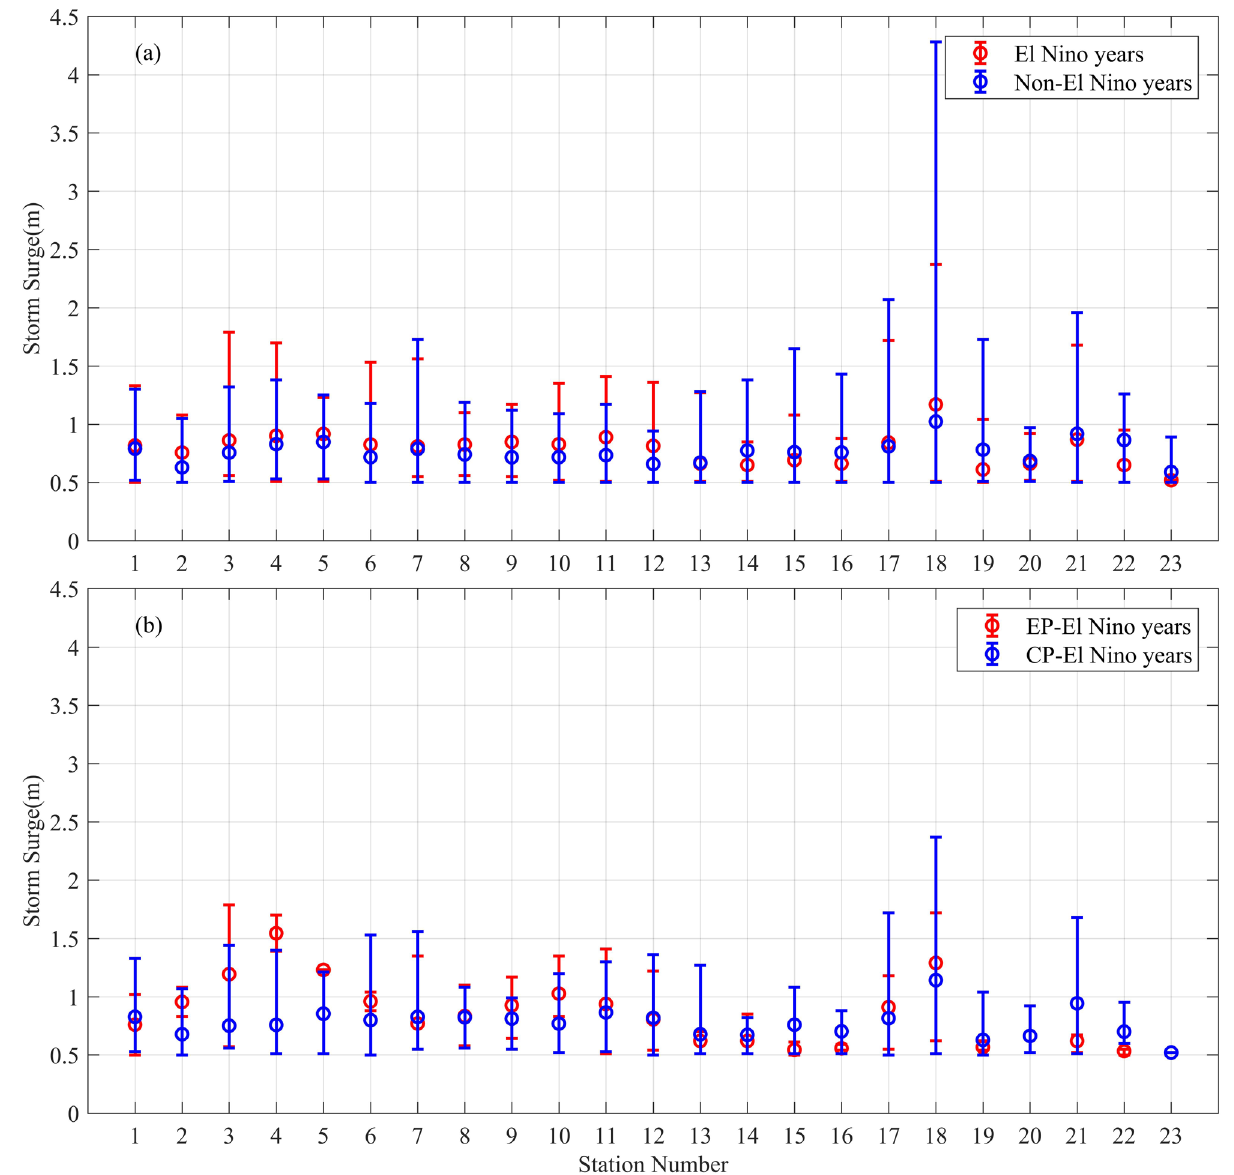
Figure 2. ( a ) Distribution of all typhoon storm surge ≥ 0.5 m at each station during certain El Niño (red) and non-El Niño (blue) years. ( b ) Same as ( a ) but for EP-El Niño (red) and CP-El Niño (blue) years. Note that there were no typhoon storm surge ≥ 0.5 m occurred during EP-El Niño years at Stations 20 and 23. The circle denotes the mean value, and the bar denotes the value range of all surges. Figures were plotted using MATLAB R2018b (http:// www. mathw orks.